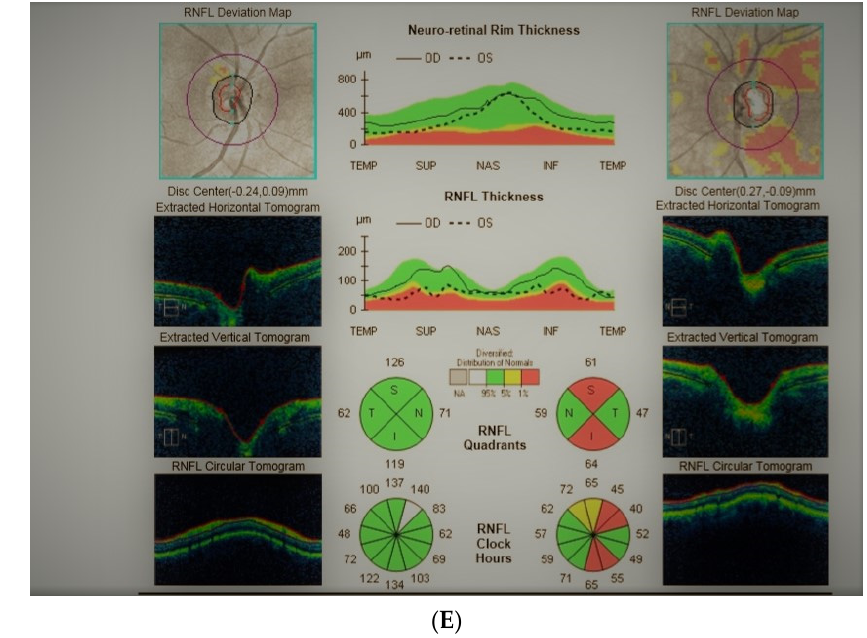
Figure 4. A 65-year-old female with optic disc meningioma. ( A ) Optic disc right eye. ( B ) Optic disc left eye. ( C ) Visual field right eye 06.2017. ( D ) Visual field left eye 06.2017. ( E ) OCT of optic disc with RNFL measurements.